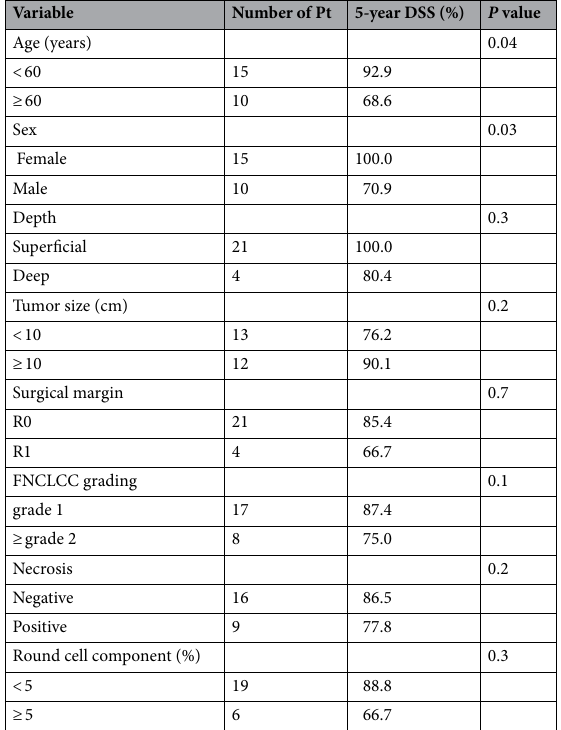
Table 5. Disease-specific survival rate using the Kaplan–Meier method and univariate analysis using the log- rank test. FNCLCC French Fédération Nationale des Centres de Lutte Contre le